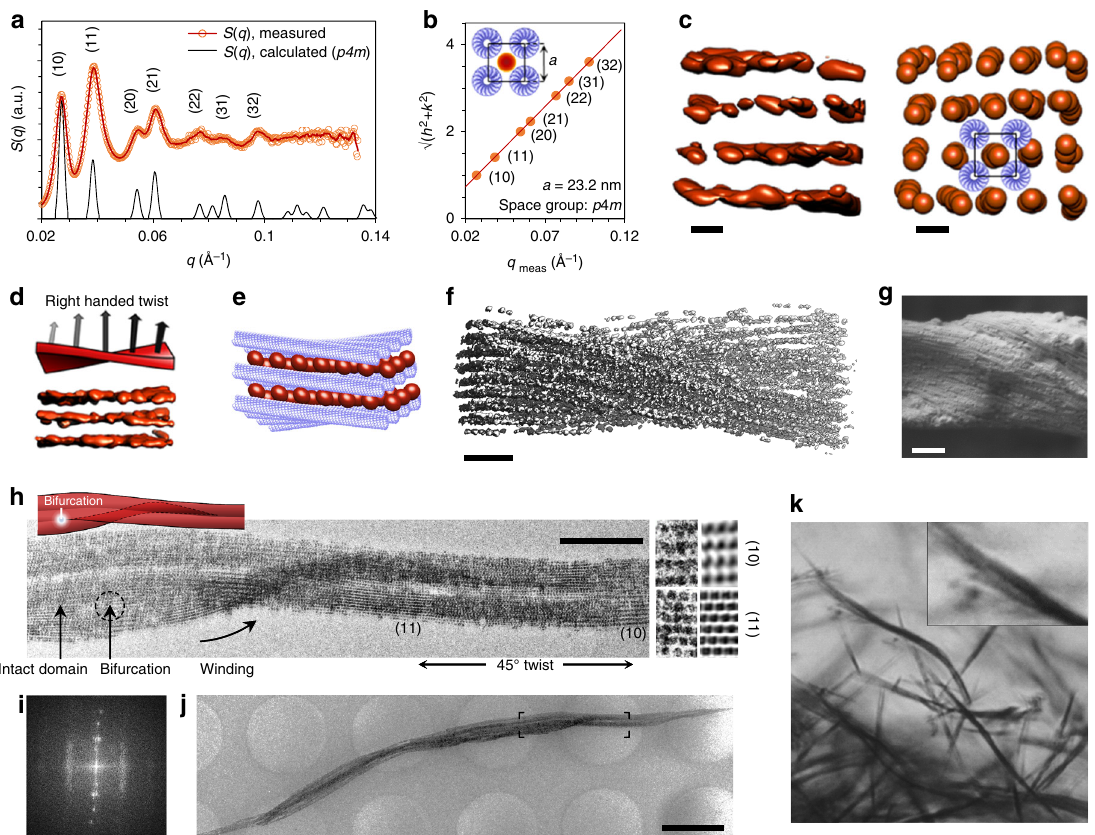
Fig. 3 Hierarchical structure of the superlattice wires. a Measured and calculated structure factor S ( q ) ( n AuNP / n TMV ~ 15). a = 23.2 nm is assumed in the calculation. b The squared diffraction peak indices plotted as a function of measured q -values. A linear fi t yields a = 23.2 nm. c A cryo-ET density map ( left ) of a superlattice wire cross section ( n AuNP / n TMV ≈ 15). The red spheres ( right ) denote AuNPs that are positioned at local density maxima ( right ) and form a twisting 2D square lattice with the indicated TMVs. d 3D density isosurface of a selected volume of the cryo-ET reconstruction showing the lattice twist on a nanoparticle level. e A schematic of the superlattice including TMVs. f Cryo-ET reconstruction of a single superlattice wire. g SEM image of a plunge- frozen and freeze-dried superlattice wire. h Cryo-TEM image (magni fi cation of j ) of several aligned superlattice domains that wind around each other. Close-up shows (10) and (11) lattice planes. A bifurcating domain is indicated with an arrow. i FFT of h shows maxima for periods of 25 nm, 16.5 nm, 10.5 nm, 8.3 nm, which correspond to (10), (11), (21), and (31) lattice plane distances (vertical direction) and maxima that refer to periods of 16.2 nm and 8.1 nm, which resemble an interparticle distance of 16.2 nm for AuNPs in the aligned rows (horizontal direction). j A low magni fi cation image of a bundle of superlattice wires. k An optical microscope image of superlattice fi bers ( n AuNP / n TMV ~ 10). The close-up highlights winding of fi bers. Scale bars : 20 nm c